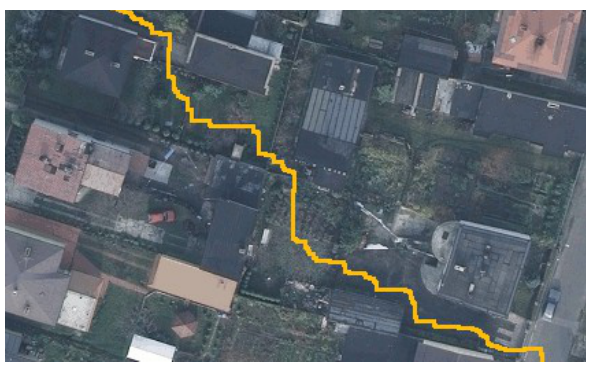
Figure 7. Part of Figure 6, enlarged